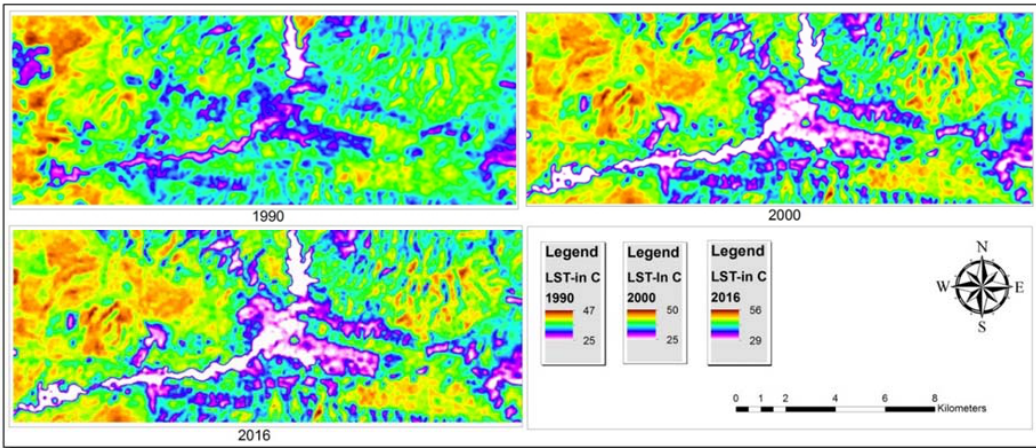
Figure 4. Land surface temperature map extract in thermal band.